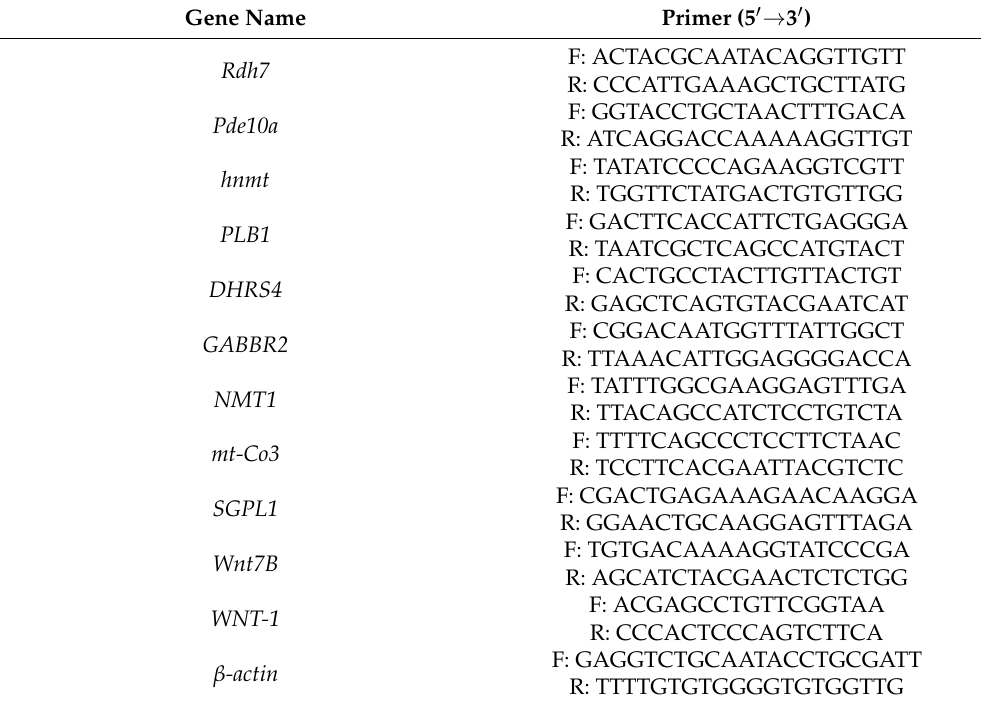
Table 1. The sequence information of primers used for